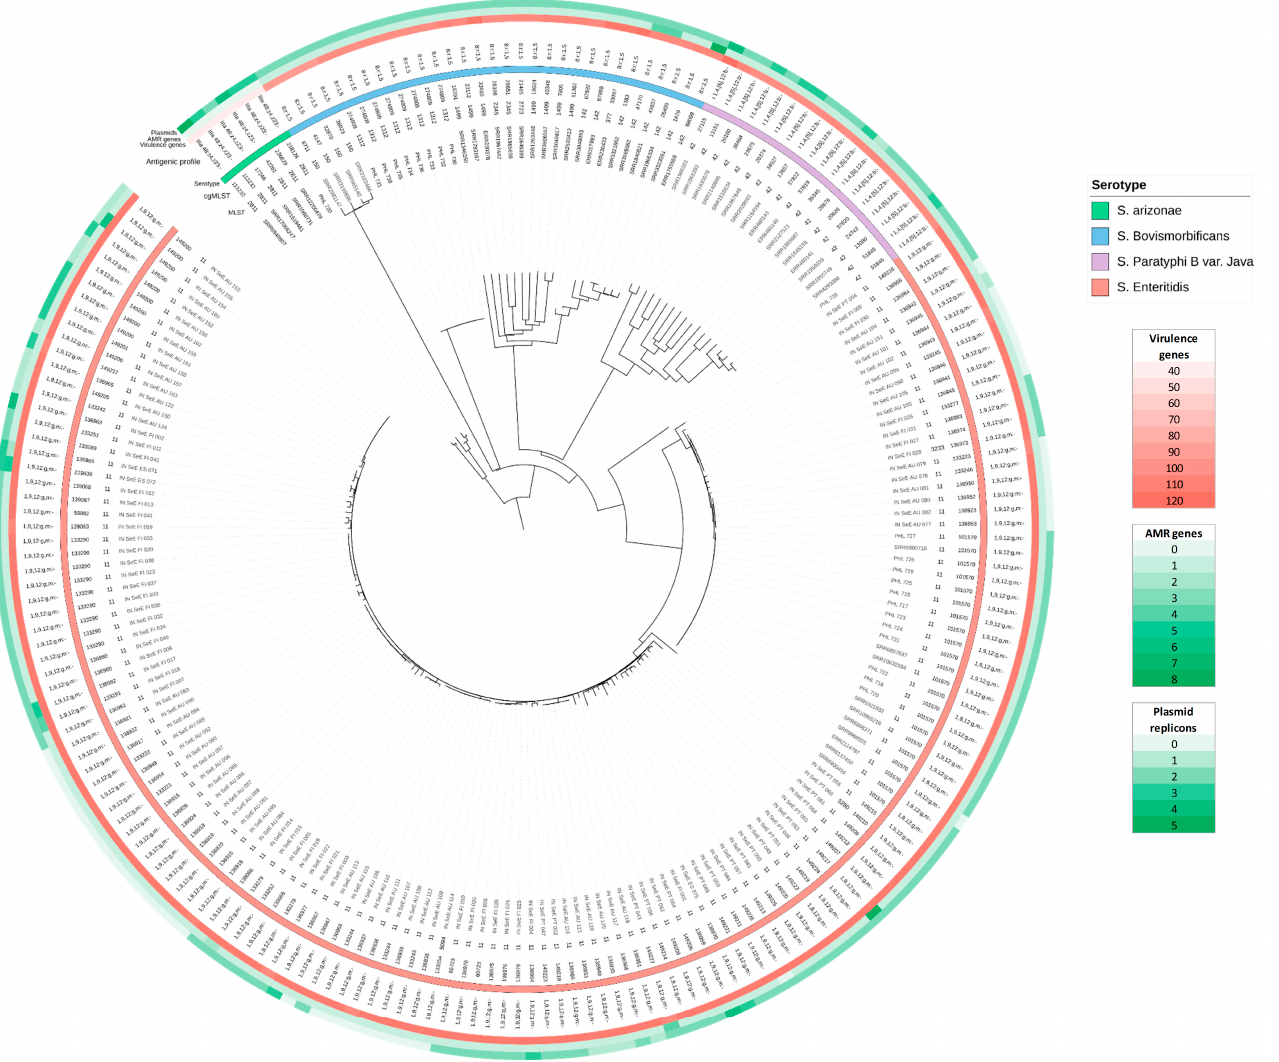
Figure 2. Core genome based minimum spanning tree containing an overview of the diversity contained in the tested dataset. The annotations are (from inner to outer rings): sample name, sequence type determined with the MLST and cgMLST scheme of Enterobase, sample serotype, antigenic profile, the number of virulence genes detected, the number of AMR genes detected and the number of plasmid replicons detected. The number of virulence genes, AMR genes and plasmid replicons are indicated according to the color legend. Full detailed information on the metadata for the characteristics of the isolates is available in Table S4.